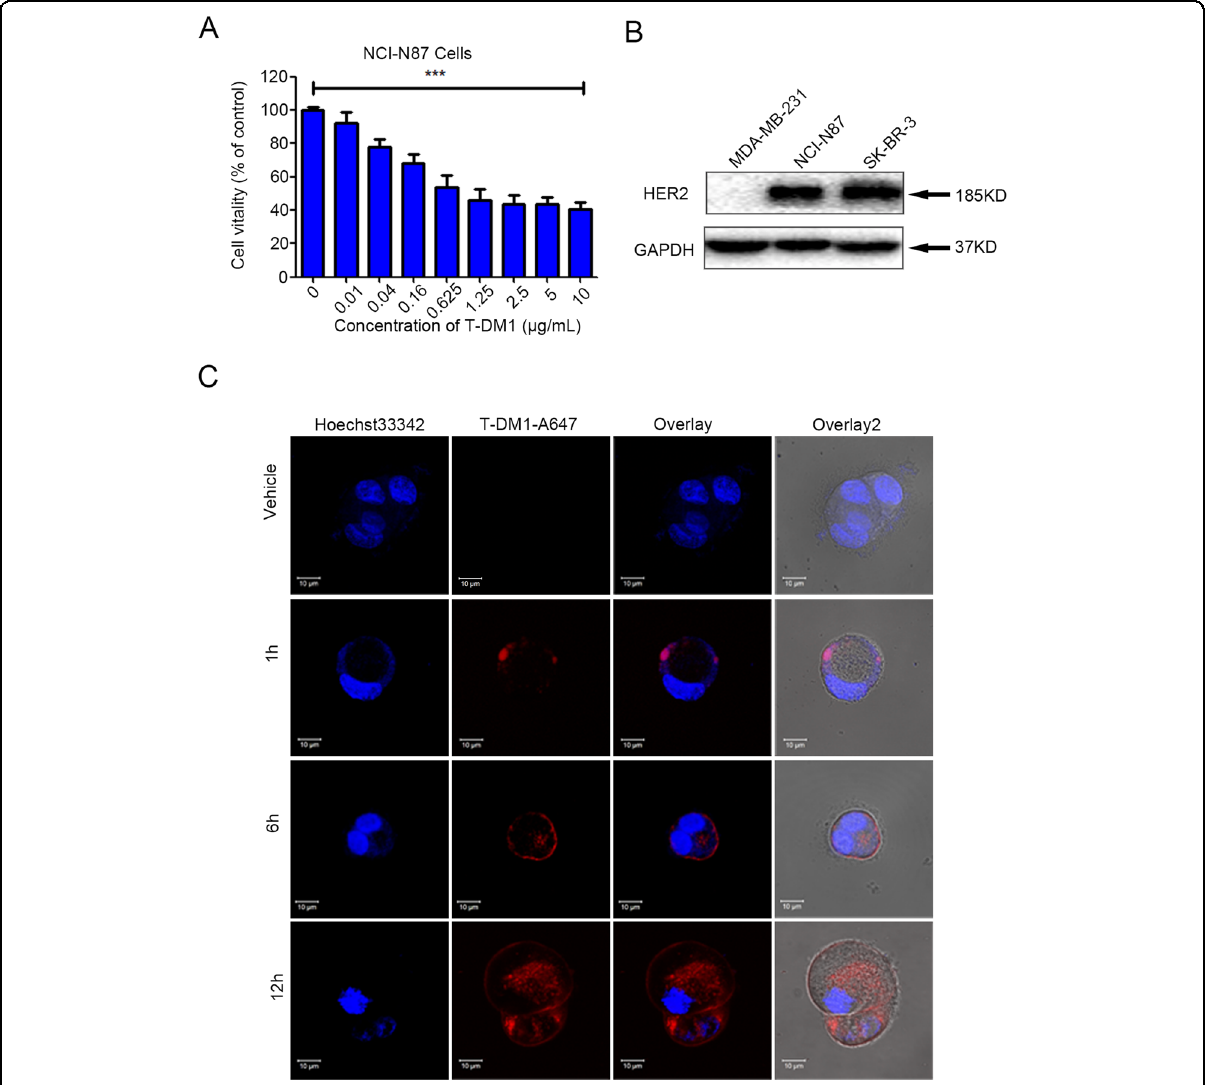
Fig. 1 T-DM1 showed antitumor effects in vitro by being internalized into HER2-positive GC cells. A NCI-N87 cells were intreated with incremental concentrations of T-DM1 for 72 h and assessed with CCK-8. The results are expressed as the mean ± S.D. (*** P < 0.001, n = 3). B The protein expression level of HER was measured by immunoblot analysis in NCI-N87, MDA-MB-231 (HER2-positive BC), and SK-BR-3 cells (HER2-negative BC). C Confocal microscopy experiments showed the whole process of fl uorescently labeled T-DM1 internalization in NCI-N87 cells. T-DM1 was labeled with the Alexa Fluor ™ 647 Microscale Protein Labeling